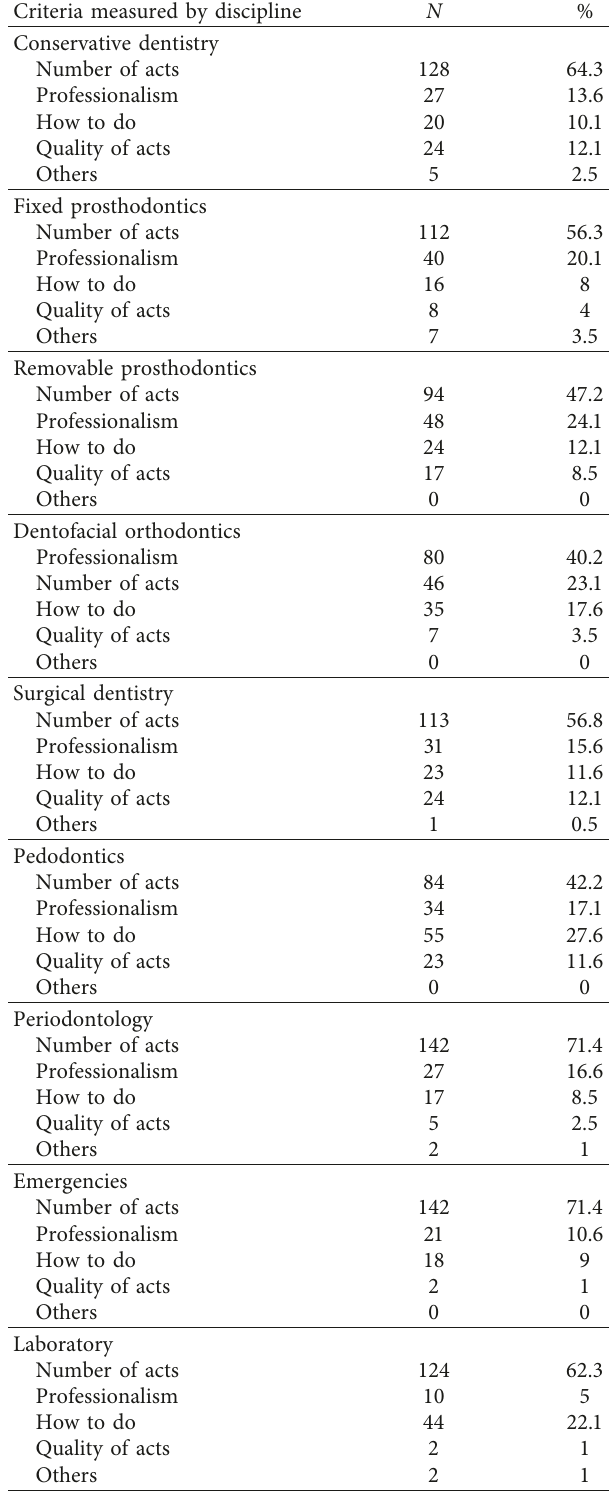
Table 1: Overall perception of theoretical knowledge assessment.